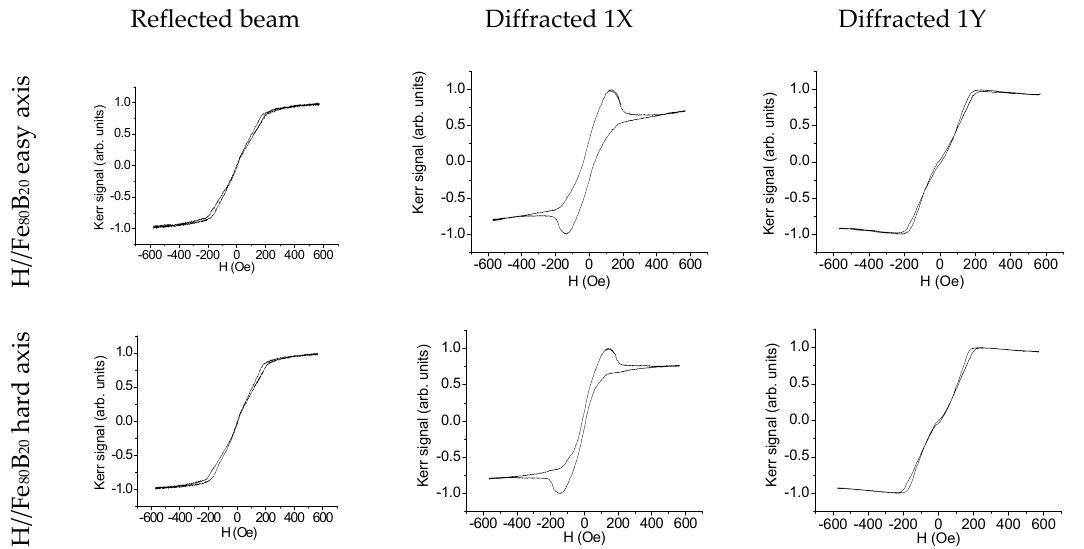
Figure 1. Hysteresis loops, both for the 0th order (reflected) and 1st X and Y diffracted orders, for arrays of 5 μ m edged Fe 80 B 20 squares separated 1 μ m with external field H parallel to the Fe 80 B 20 easy and hard axes.